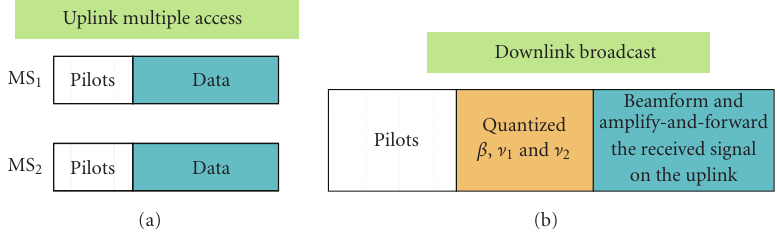
Figure 3: Block diagram of the system